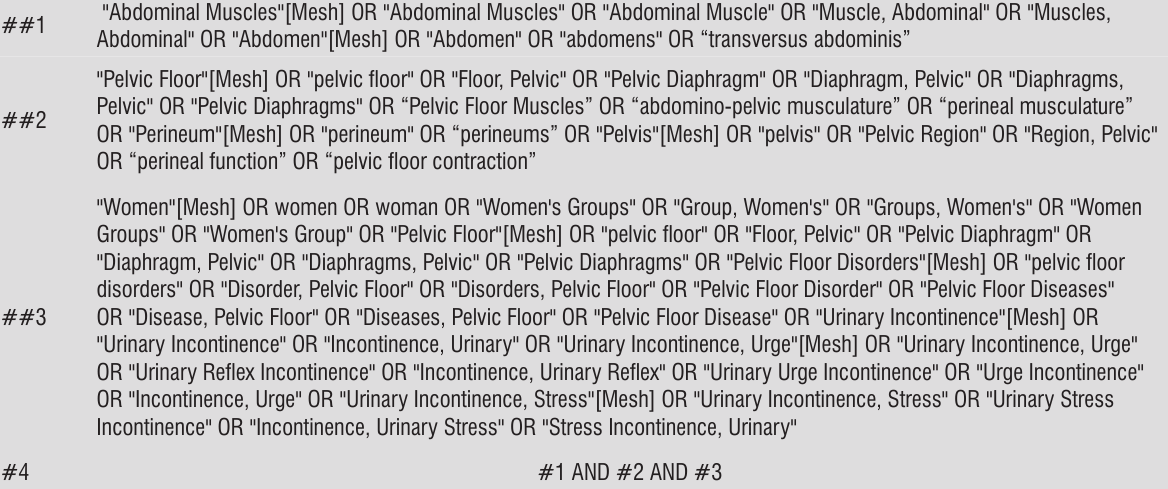
Table 1 - Research strategy used on